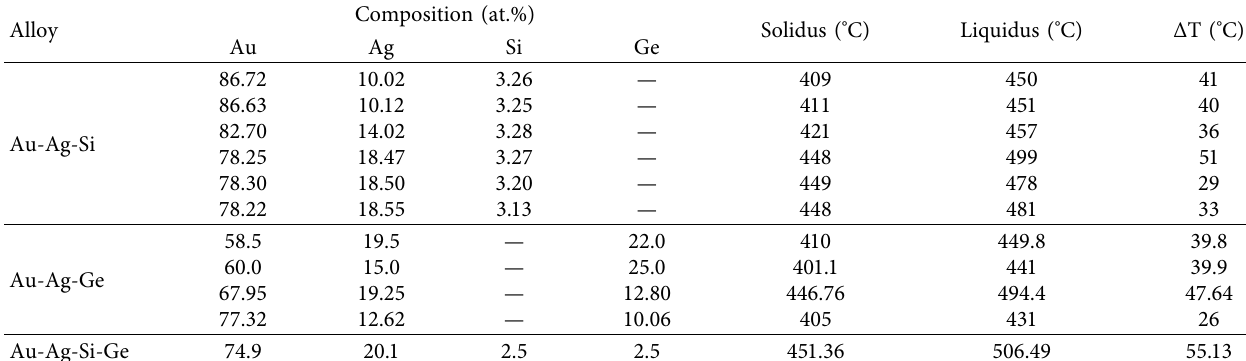
Table 4: Au-Ag-based medium-temperature solders [70].